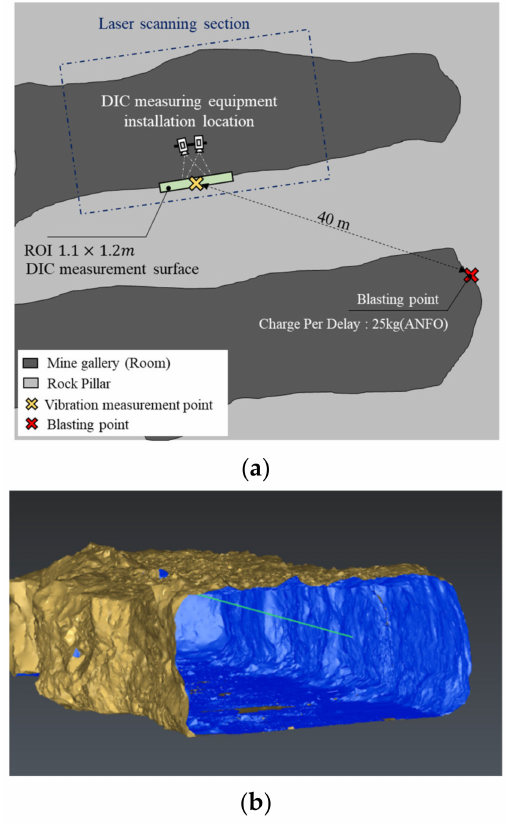
Figure 2. Layout of blasting face and measurement point: ( a ) description of the measurement and blast location inside the mine tunnel; ( b ) tunnel interior by laser scanning. Table 2. Blasting design of